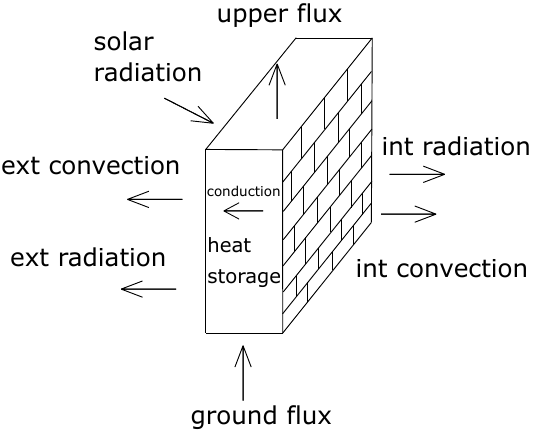
Figure 6. Heat fluxes in the considered wall.